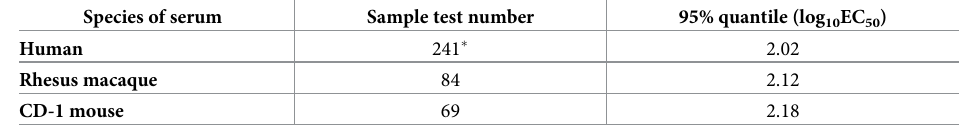
Table 3. Positive serum cut-off for the Z-RVP-384 assay in human, rhesus macaque and mouse